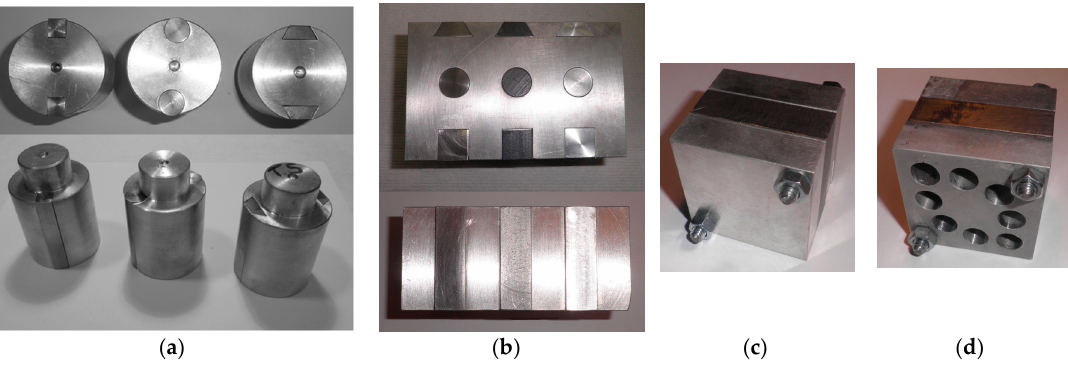
Figure 1. Hybrid part specimens with different geometries and combinations of materials for trials of: ( a ) turning; ( b ) milling; ( c ) drilling; and ( d ) repair and maintenance of holes by drilling.